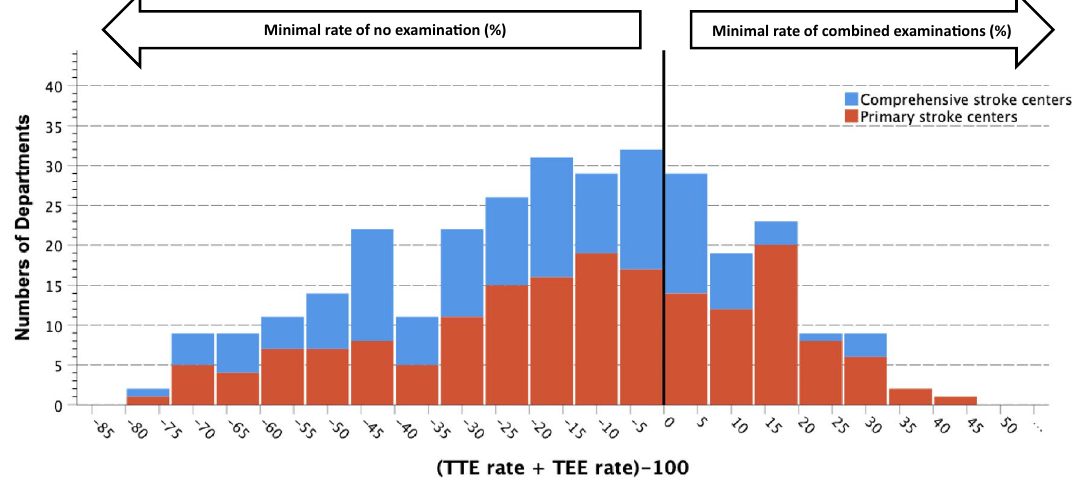
Fig. 3 Rates of patients undergoing no-, or combined echocardiographic examinations and numbers of stroke units for which these rates were observed. (For interpretation: 100: In all patient no examination was performed at all; 75: in at least 75% of patients no examination − − was performed; 0: In all patients one examination has been performed; 10: In at least 10% of patients combined examinations have been + done; 100 In all patients combined examinations have been + =